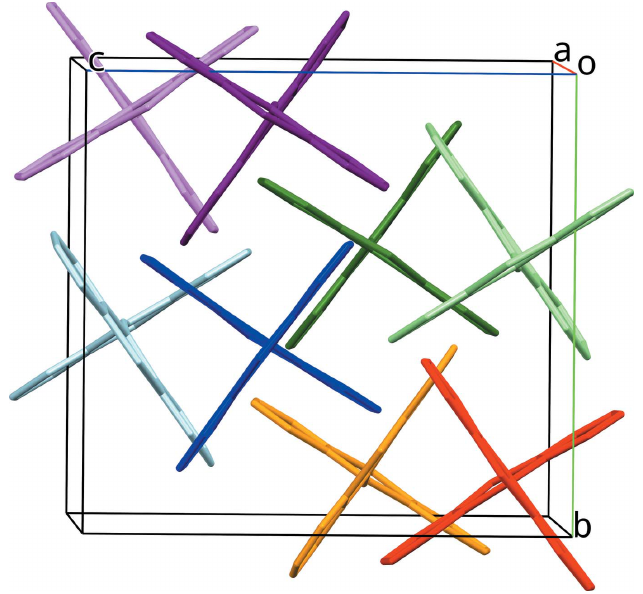
Figure 6 Crystal packing of (II). Molecules occupying similar positions in (I) and (II) are drawn with the same colour to illustrate the similarities between (I) and (II).